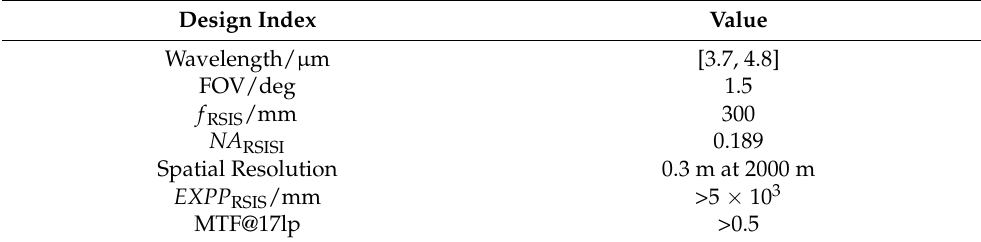
Table 5. RS design index.